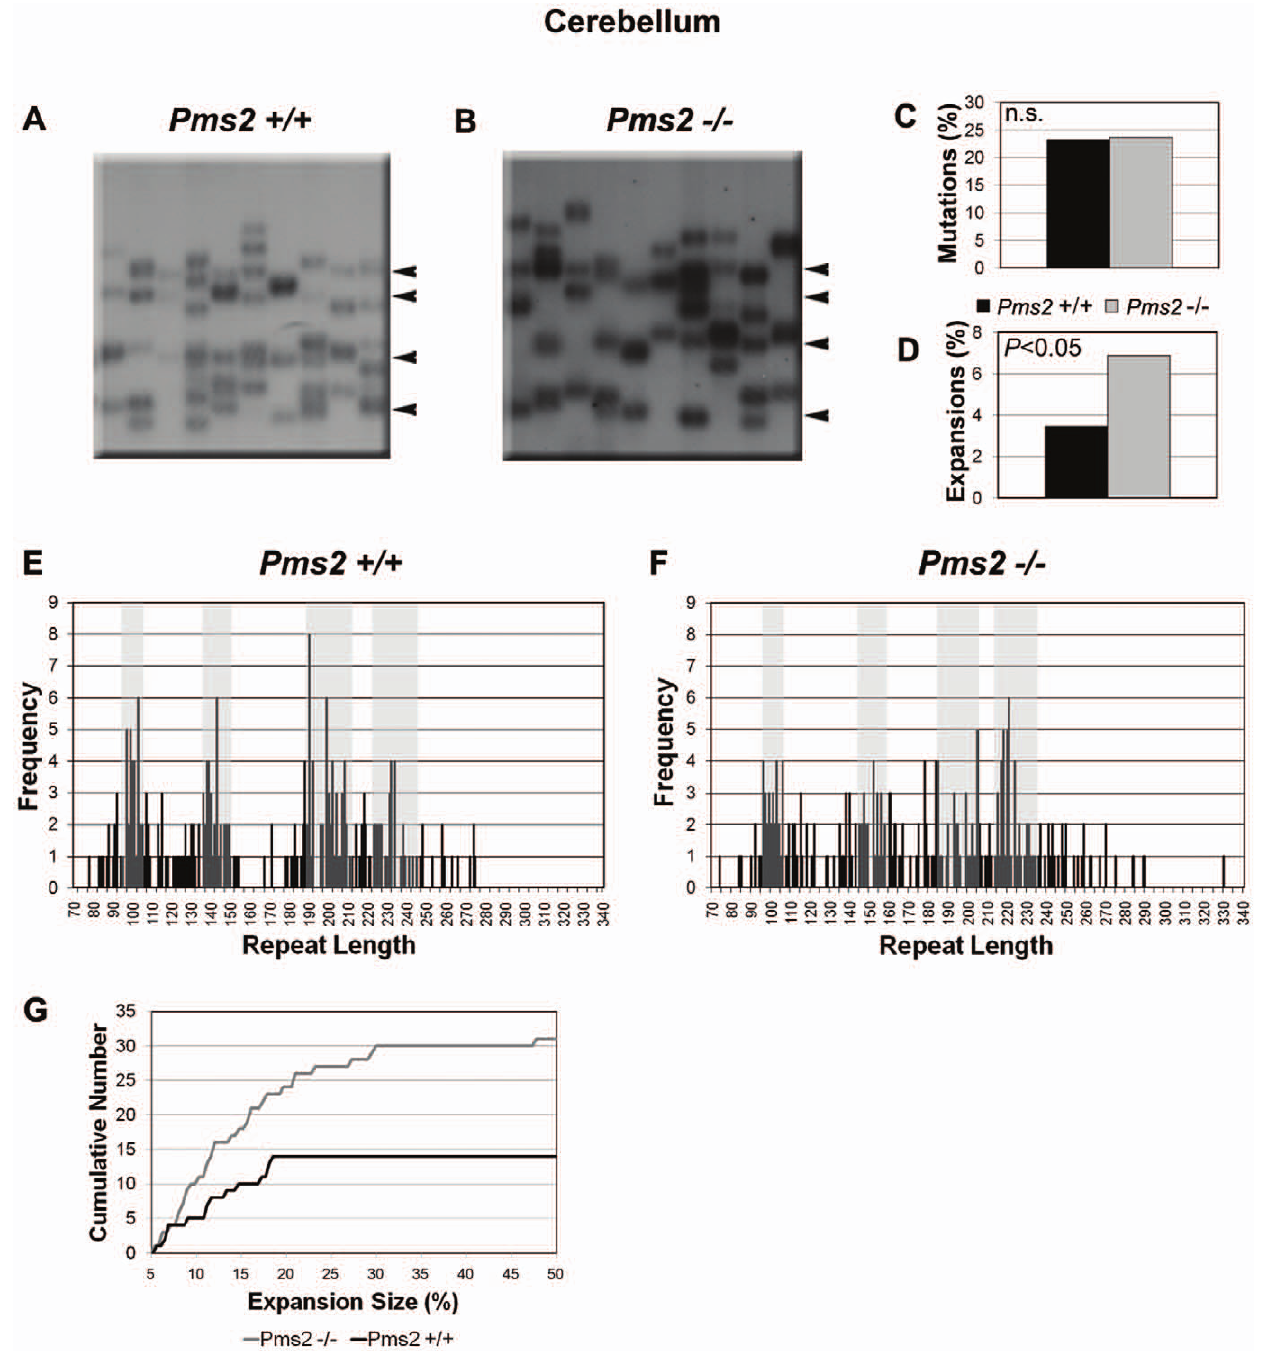
Figure 3. Absence of Pms2 increases somatic expansion load of the (GAA ? TTC) n sequence in cerebellum. Analysis of instability in cerebellum of Pms2 + / + and Pms2 2 / 2 mice. Progenitor allele lengths of 232, 199, 143, and 99 repeats for (A) Pms2 + / + , and 224, 195, 152, and 101 repeats for (B) Pms2 2 / 2 are indicated by arrowheads. Mutation load and expansion load, calculated from analysis of , 400 molecules per genotype, are shown in C and D, respectively. Panels E and F indicate the distribution of repeat lengths for all SP-PCR products of (E) Pms2 + / + and (F) Pms2 2 / 2 . These graphs are therefore an exact, combined representation of all blots analyzed for Pms2 + / + and Pms2 2 / 2 cerebrum. The number of products measured at each repeat length is on the Y-axis. Note that the actual frequency of products at the progenitor lengths may be slightly higher than the counted frequency, because a single band may represent PCR products amplified from multiple progenitor molecules. The gray bars represent the progenitor allele lengths + / 2 5%. Lines within the gray bands represent unchanged bands. Lines outside of these ranges represent mutations. Those to the right of the rightmost band represent expansions, those to the left of the leftmost band represent contractions, and those in the middle represent unclassified mutations. Products outside of these ranges were counted as mutations. Panel G shows the cumulative number of products observed with increasing expansion size. Expansion size was calculated as the percent increase in repeat length above the largest progenitor. An incremental increase is seen in Pms2 2 / 2 versus Pms2 + / + mice at all expansion sizes, but the increase in magnitude of the difference at higher expansion sizes points to the role of Pms2 in preferentially suppressing large expansions in the cerebellum. doi:10.1371/journal.pone.0047085.g003 PLOS ONE |